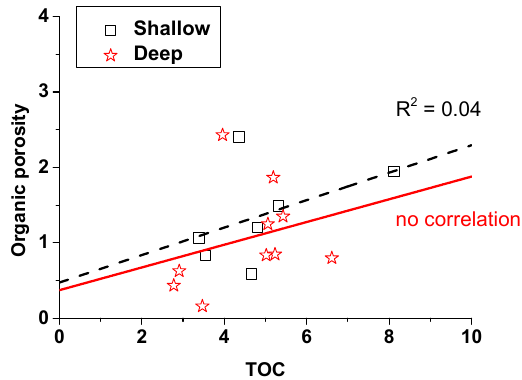
Figure 14. The correlation between porosity and inorganic porosity.